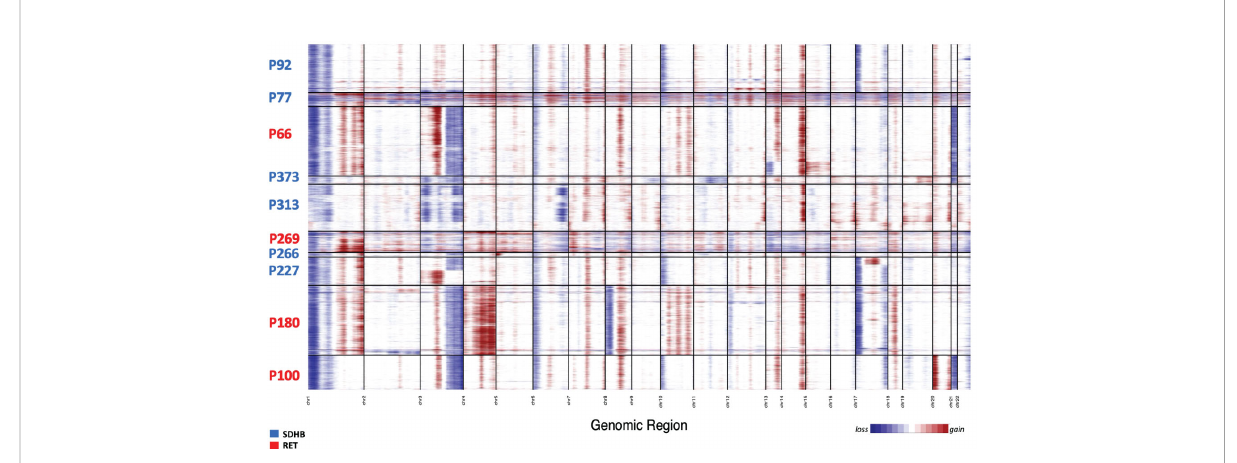
FIGURE 2 Heatmap of inferred CNVs of NE cells (immune clusters and stromal clusters were applied as reference). The patient IDs are colored by the mutation